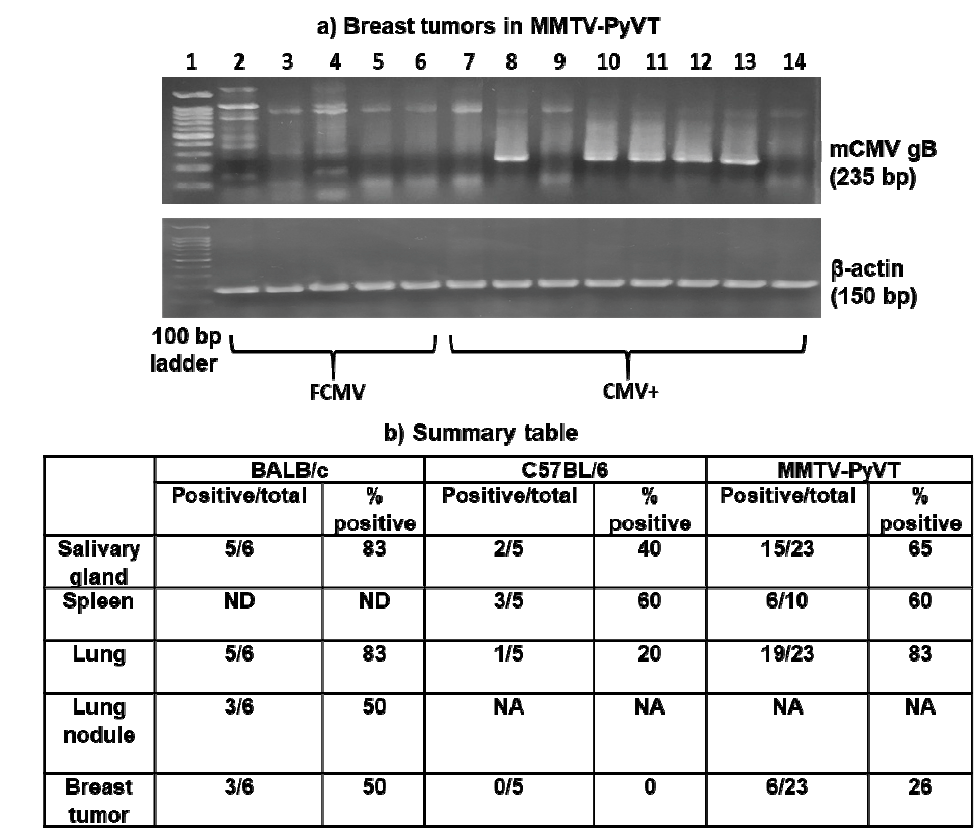
Figure 6. The DNA for mCMV glycoprotein B (gB) was detected in MMTV-PyVT mice latently infected with mCMV. The representative gel shows the detection of DNA for mCMV gB in breast tumors from five filtered control (FCMV; lanes 2–6) and eight mCMV-treated (lanes 7–14) MMTV-PyVT mice ( a ). Lane 1 = 100 bp ladder. A positive detection of mCMV gB DNA was identified by a band at 235 base pairs (bp). Beta-actin (150 bp) was used as an internal control. The number of tissues, nodules or breast tumors positive for mCMV gB DNA from each animal model was summarized in Panel ( b